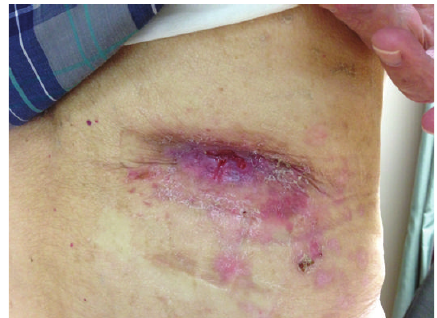
Figure 3: Resolution of mass after chemotherapy and radiation